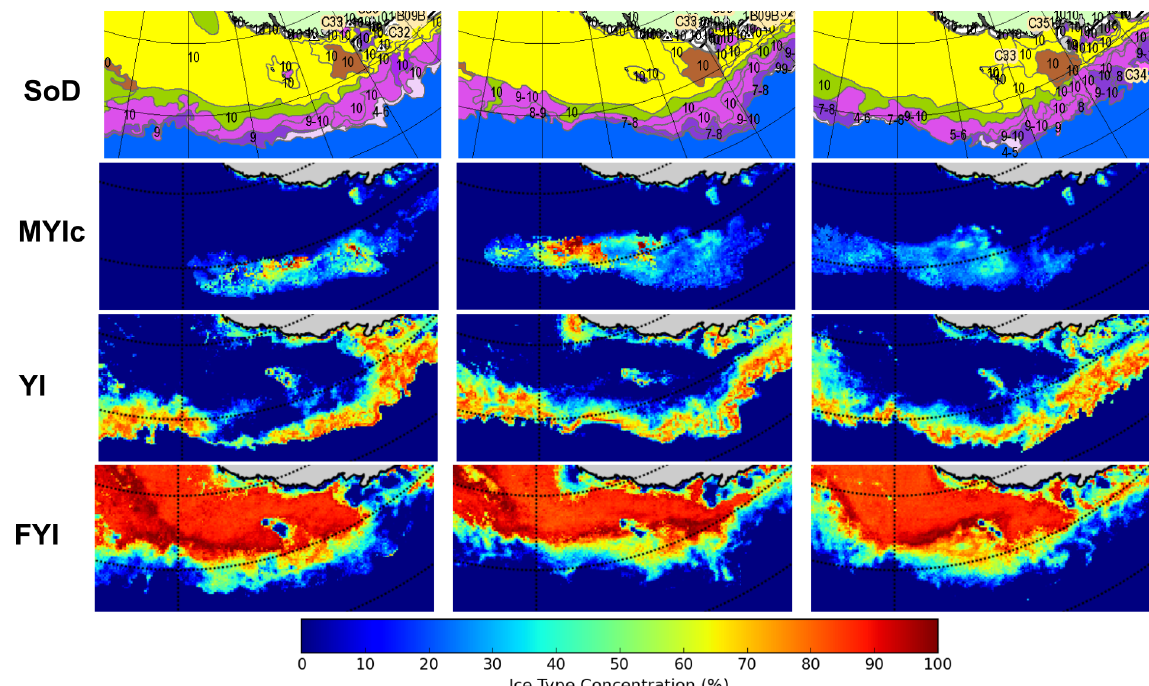
Figure 12. Outer Ross Sea, off Wilkes Land, August and September 2018; top to bottom: SoD charts from AARI, corrected MYI, YI, FYI concentrations; left to right: 2 August, 30 August, 27 September